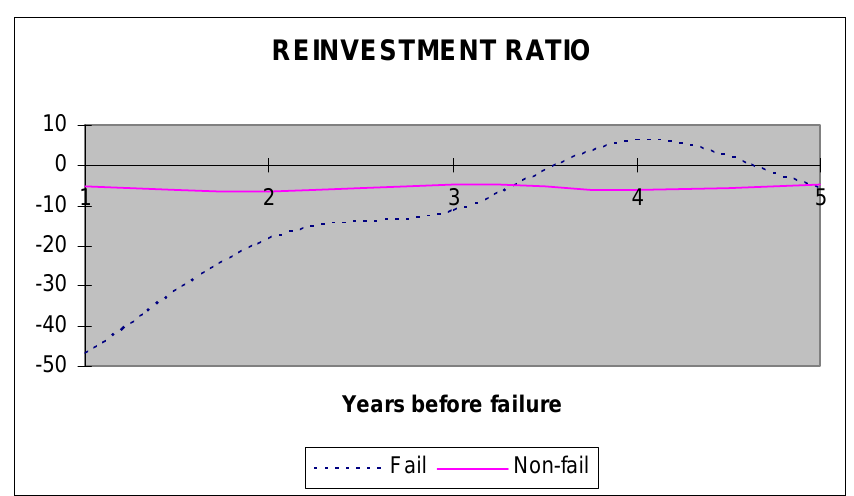
Figure 3: Reinvestment ratio REINVESTMENT RATIO